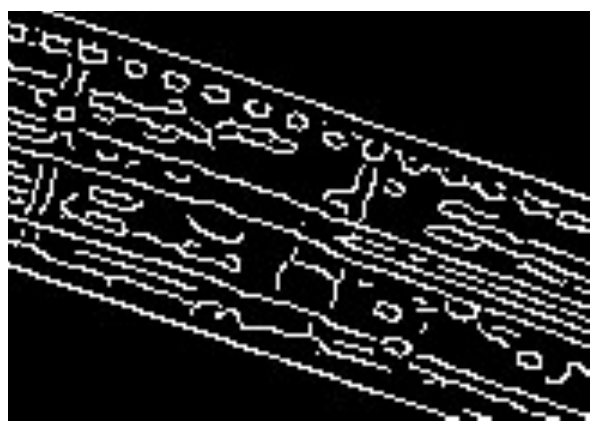
Figure 11: Result of Edge Drawing. Road centerline and short lane marking are extracted.